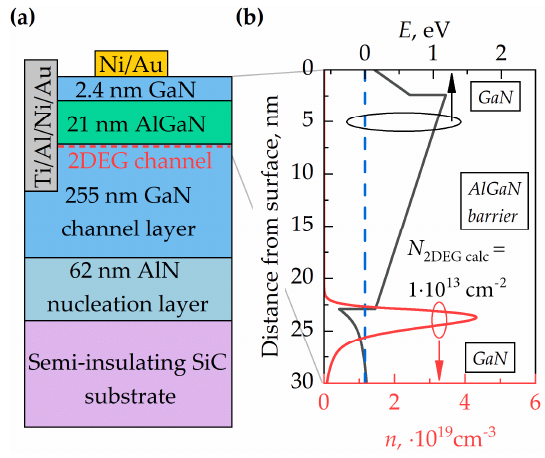
Figure 1. ( a ) Schematic of the thin high electron mobility transistor (T - HEMT) structure cross section with ohmic and Schottky contacts and ( b ) the calculated band diagram and electron density distribution in the upper layers of the heterostructure.